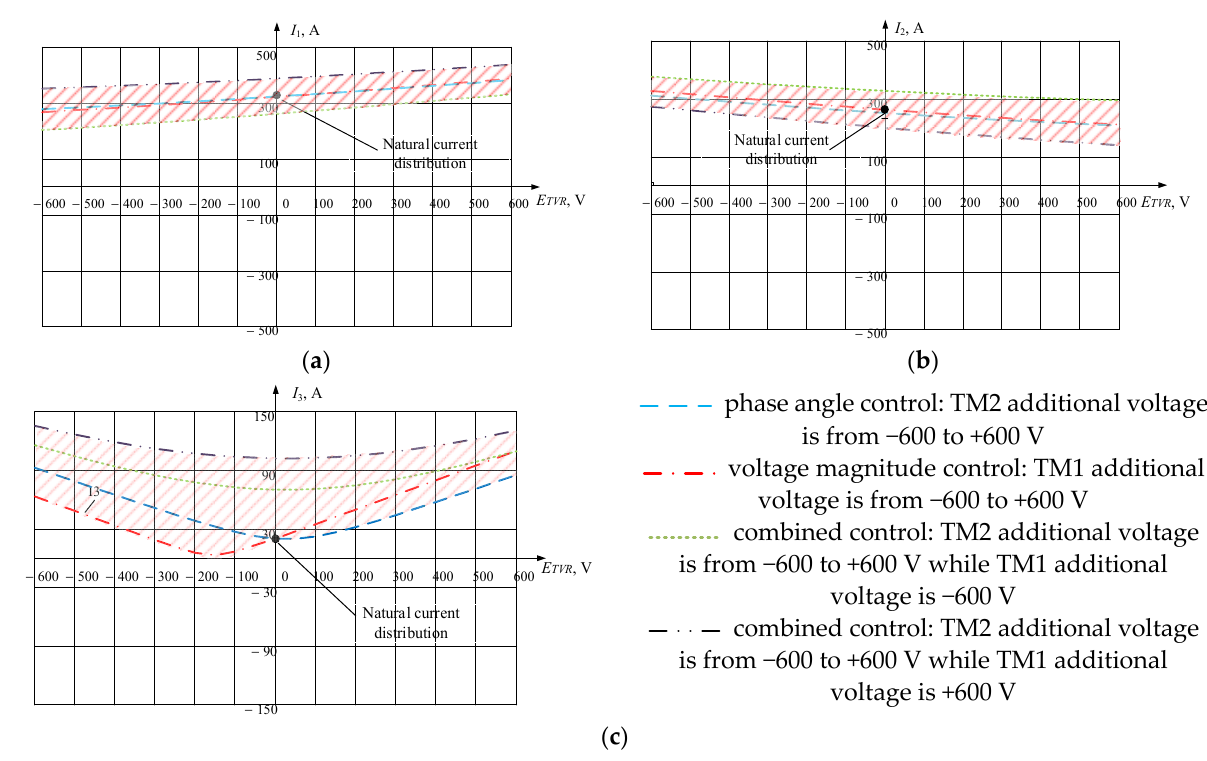
Figure 12. Dependences of RMS currents under voltage magnitude, phase angle, and combined control modes: ( a ) I 1 , ( b ) I 2 , and ( c ) I 3 .